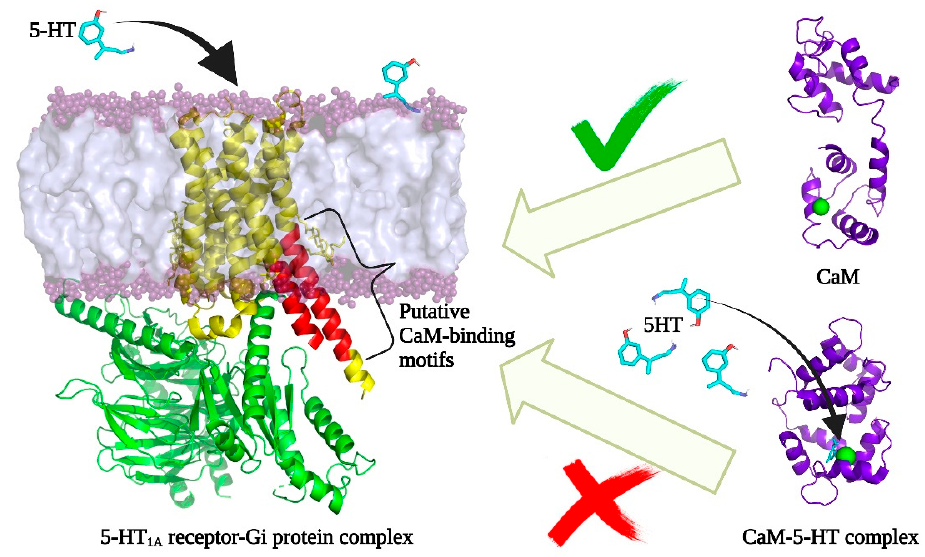
Figure 5. Scheme of a possible indirect modulation of 5-TH on the serotonin-bound serotonin 1A (5-HT 1A ) receptor through CaM. On the left is shown 5-HT 1A receptor-Gi protein complex; 5-HT 1A receptor in yellow cartoons (red cartoons represent CaM interaction sites), and Gi protein in green cartoons, and the lipid bilayer in purple surface. CaM and CaM–5-HT complex are shown in purple cartoons and 5-HT in cyan stickers. The structural model of the 5-HT 1A receptor-Gi protein complex was obtained from the PDB code 7E2Y.pdb, for the CaM and CaM–5-HT complex 1Y0V.pdb and 1A29.pdb, respectively.